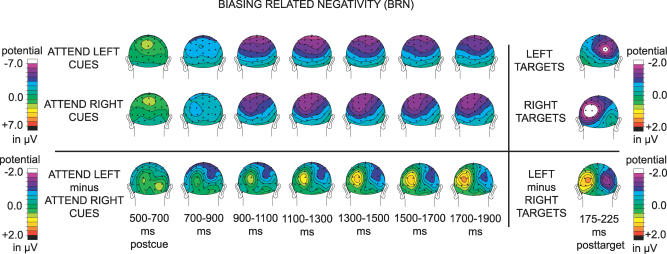
Pretarget Visual Cortex BiasingGrand-average (n = 13) ERP topographic plots (back view) time locked to attend-left cues (upper left row), attend-right cues (middle left row), and the difference-wave plots for the attend-left cues minus the attend-right cues (lower left row), averaged over 200-ms bins, starting 500 ms post-cue until the onset of late targets at 1,900 ms. The far right column shows N1 latency back-view topographic plots for left targets (upper right), right targets (middle right), and the left-minus-right target difference wave (lower right). All target-related activity is corrected for overlap from previous cue activity. Note the build up and then maintenance of the biasing-related negativity BRN over the occipital cortex contralateral to the direction of attention, and also note the similarity of the scalp-potential distributions of this biasing-related activity to the N1 differences between left and right targets.